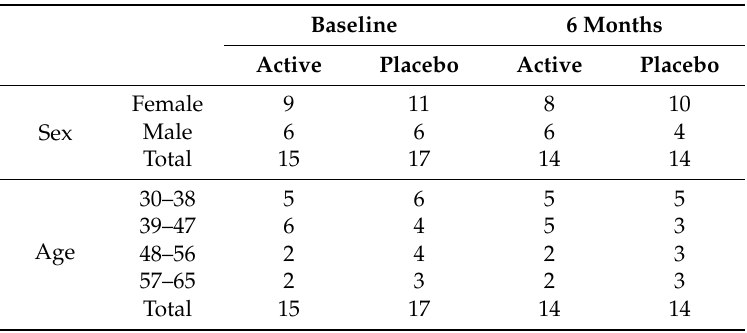
Table 1. Demographic information of final